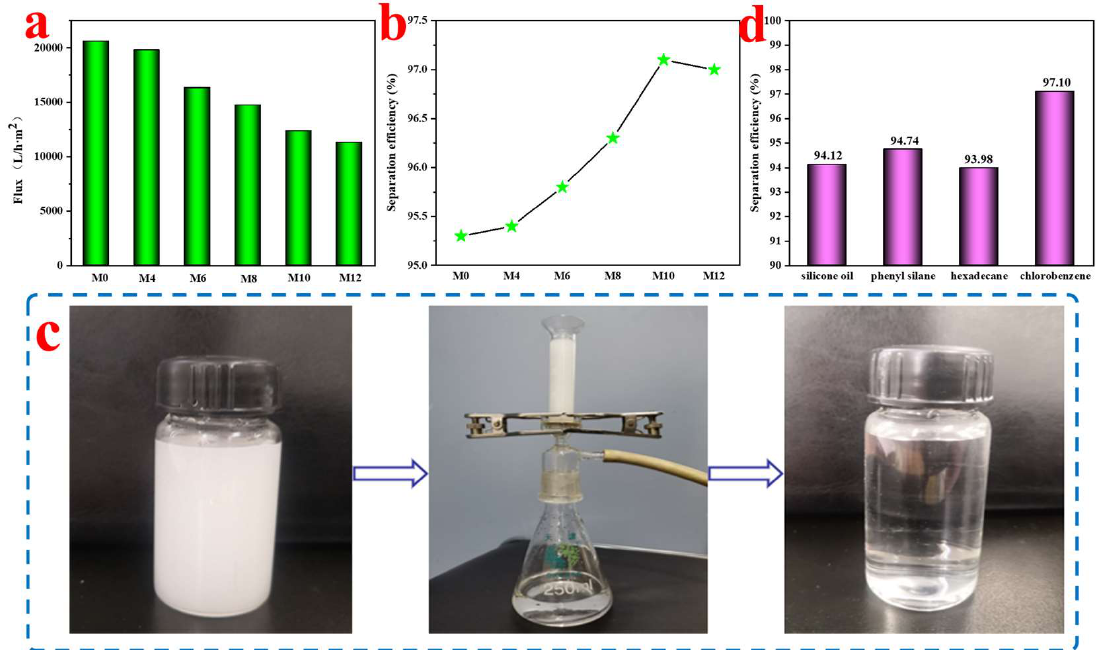
Figure 12. Water flux and oil/water separation performance of ZIF-8/PPS fiber membranes. ( a ) Wa- ter flux test of ZIF-8/PPS fiber membranes (M0: untreated; M4: 4 h; M8: 8 h; M10: 10 h; M12: 12 h); ( b ) oil/water separation performance (M0: untreated; M4: 4 h; M8: 8 h; M10: 10 h; M12: 12 h); ( c ) digital photos of M10 in the separation process of chlorobenzene; ( d ) separation performance of ZIF- 8/PPS fibers for different emulsions.